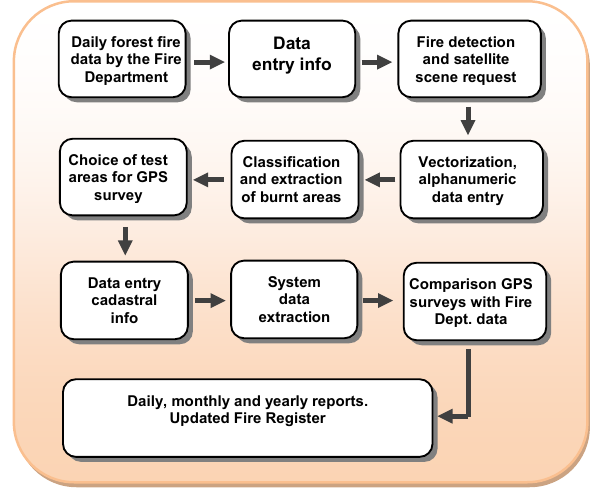
Figure 1. Remote sensing update flow